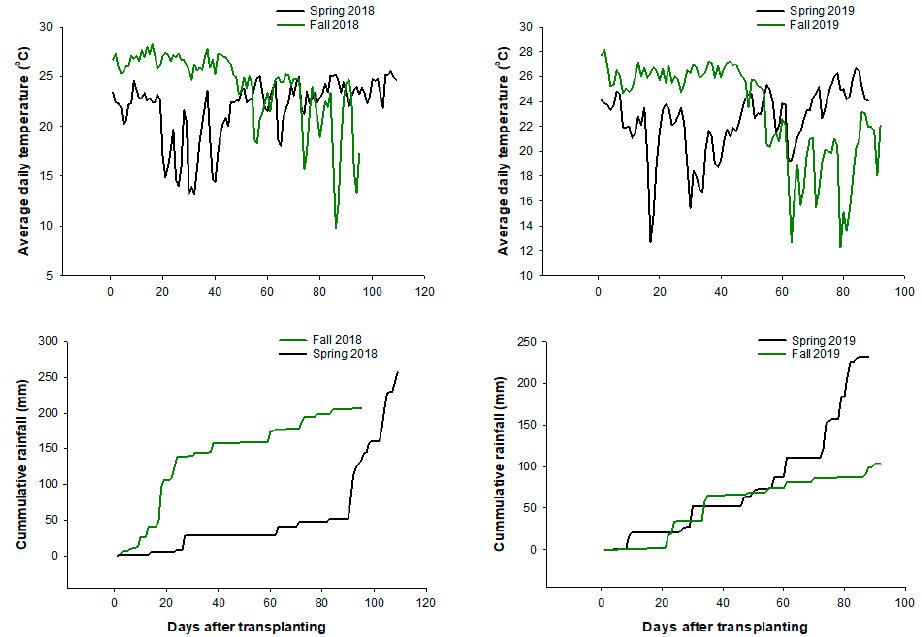
Figure 1. Average daily air temperatures and cumulative precipitations during the spring and fall tomato growing seasons in both 2018 and 2019 in Immokalee, Florida.